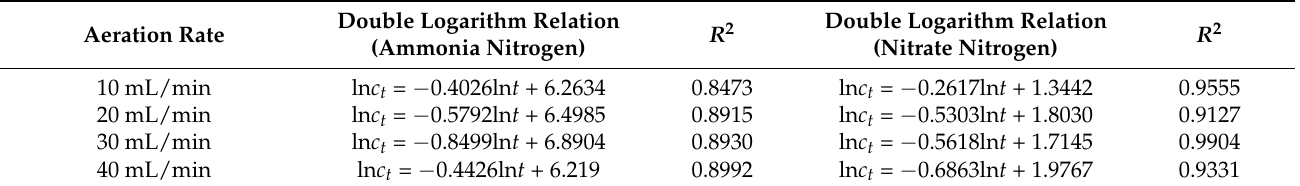
Table 4. Double logarithm linear expression between ammonia nitrogen/nitrate nitrogen content in sediment and test days under aeration.